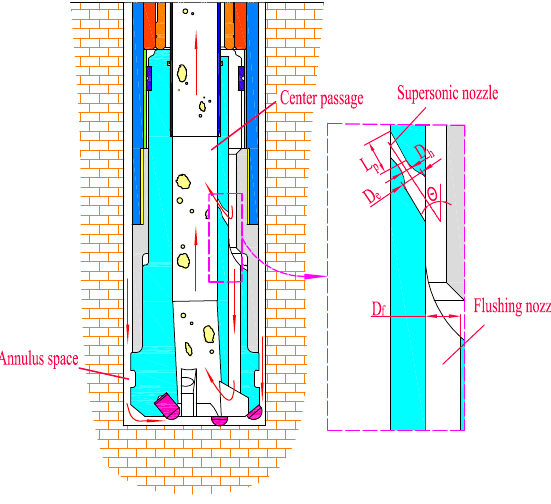
Figure 1. Schematic of the reverse ‐ circulation drilling method.